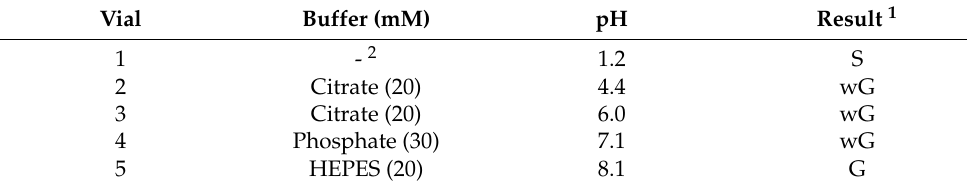
1 Gel formation was qualitatively analysed by the vial inversion technique. 2 The sample at pH = 1 was prepared by adding 20 µ L of concentrated HCl. S: soluble, wG: weak gel, and G: gel. The buffers were commercially available and, when needed, the pH was adjusted using NaOH or HCl. See Figure S3 for the results of the vial inversion